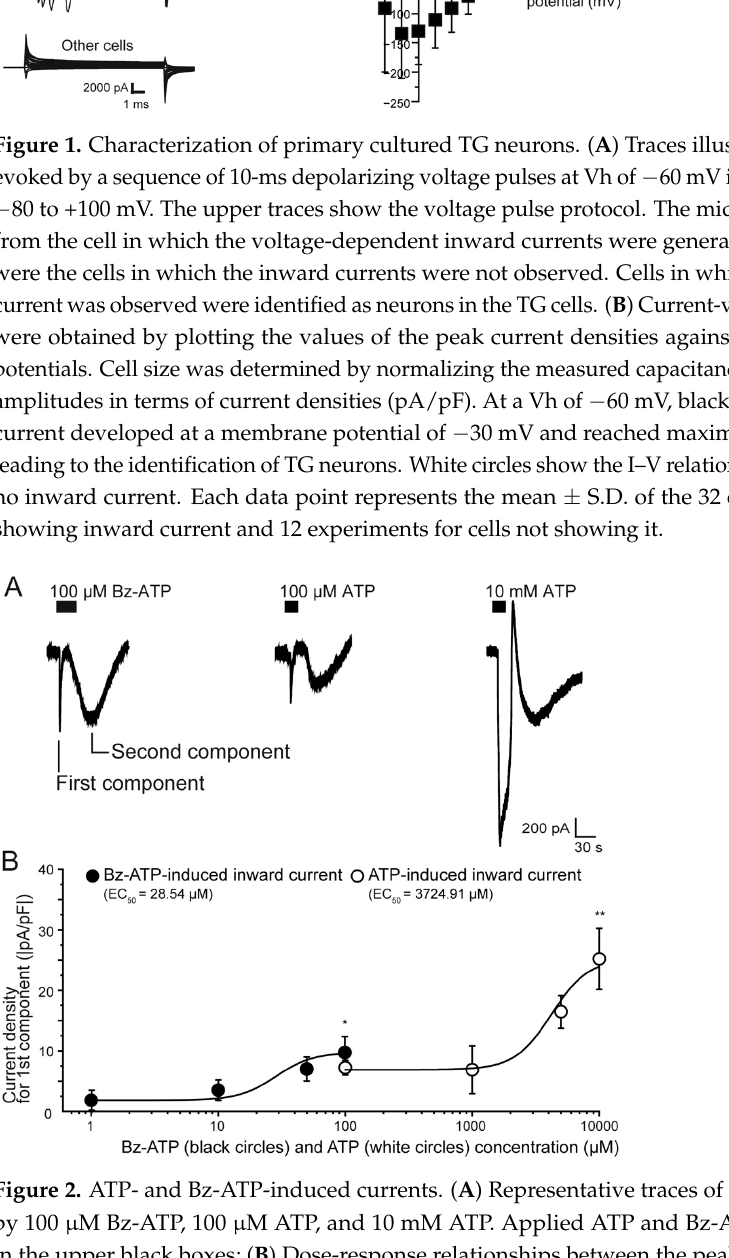
Figure 2. ATP- and Bz-ATP-induced currents. ( A ) Representative traces of inward currents induced by 100 µM Bz-ATP, 100 µM ATP, and 10 mM ATP. Applied ATP and Bz-ATP protocols are shown in the upper black boxes; ( B ) Dose-response relationships between the peak current densities of the first current component of the agonist-induced inward currents vs. each concentration of Bz-ATP (1, 10, 50, and 100 µM) and ATP (100 µM, 1 mM, 5 mM, and 10 mM). Curves (solid lines) on the semilogarithmic scale were fitted to the equation described in the text. Note that a high concentration of ATP (10 mM) elicited inward currents, which showed slow inactivation and long-lasting properties. Each data point represents the mean ± SD of five experiments. Statistically significant differences between data points are indicated by asterisks. * p < 0.05 vs. 1 µ M Bz-ATP; ** p < 0.05 vs. 100 µ M